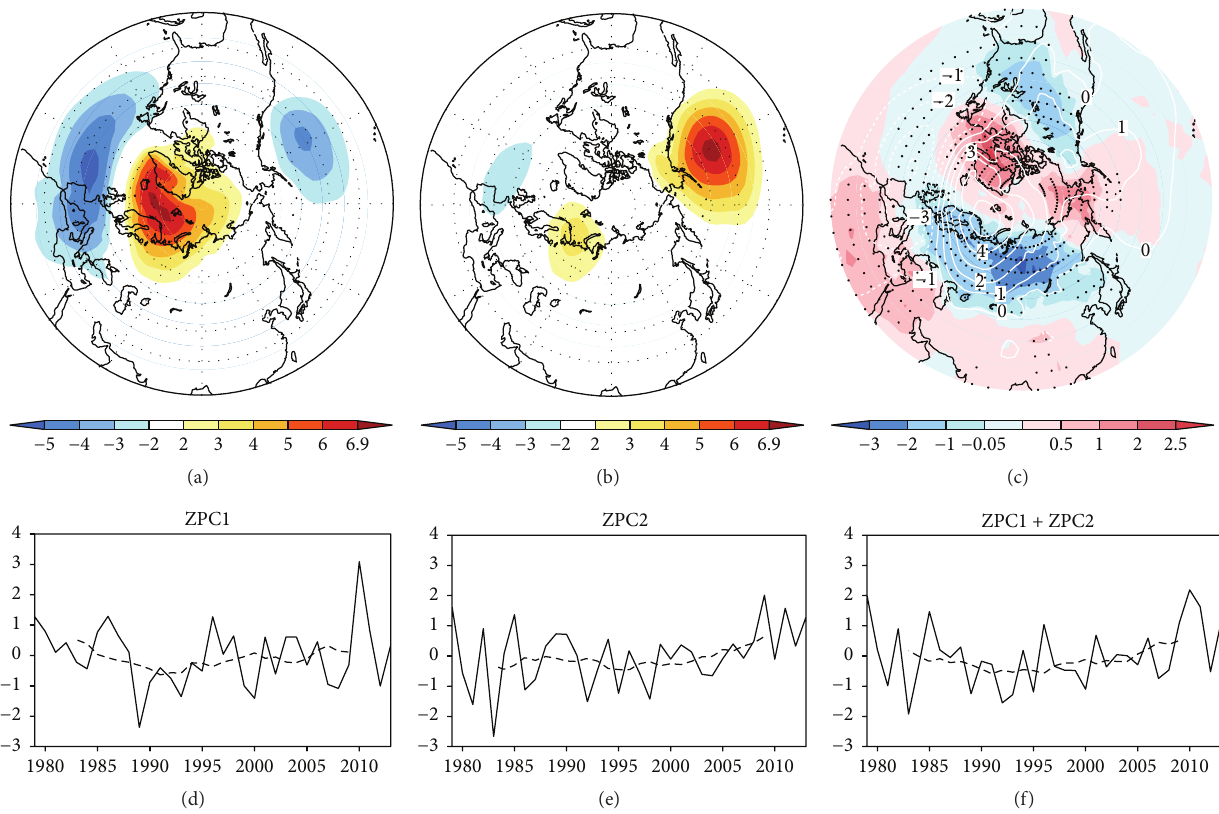
Figure 10: The spatial distribution of the first two leading modes of the extratropical Z1000 in the Northern Hemisphere and their associated circulation anomalies. (a, d) are for EOF1 and its corresponding ZPC1 and (b, e) are EOF2 and ZPC2, respectively. The units are gpm for Z1000 in (a, d). (c) The regression coefficients of SAT and Z1000 in relation to ZPC1 + ZPC2. (f) The units are gpm for Z1000 and K for SAT. Dashed lines in (d, e, f) denote the corresponding 9-yr running mean for the original time series (solid line). The dotted areas in (c) indicate significantly regressed SAT exceeding 0.05 for the 𝐹